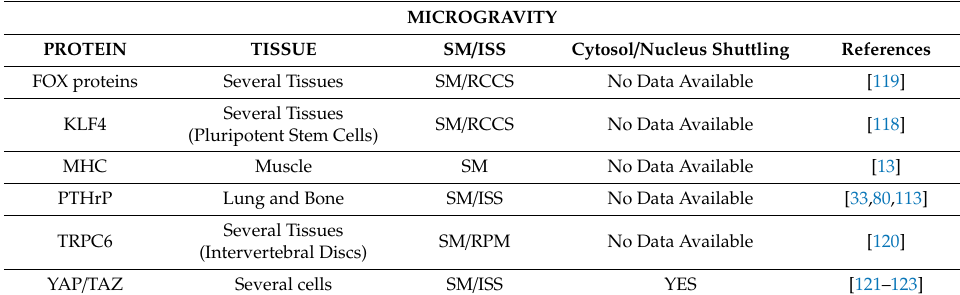
Table 2. List of Mechanosensors in Microgravity conditions and cytosol / nucleus shuttling. SM, Simulated Microgravity. ISS, International Space Station. RPM, Random Positioning Machine. RCCS, Rotary Cell Culture